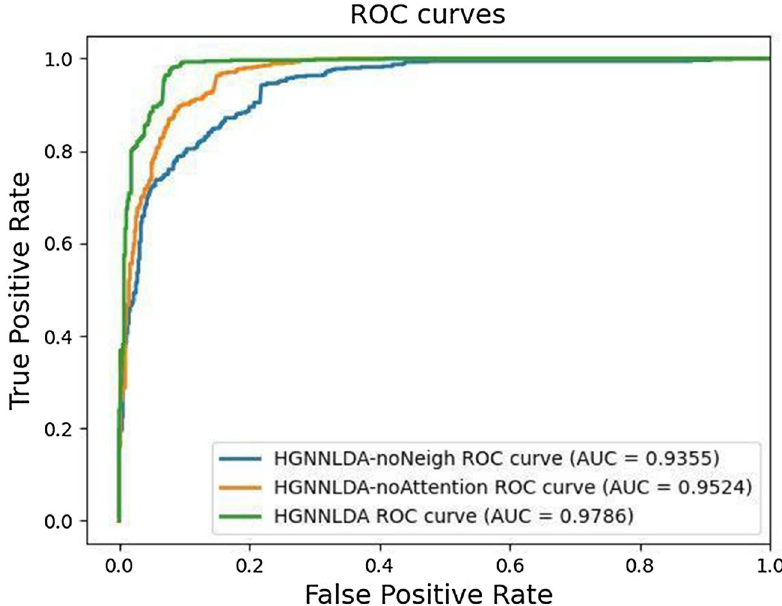
Figure 1. ROC curves of HGNNLDA based on fivefold cross-validation.